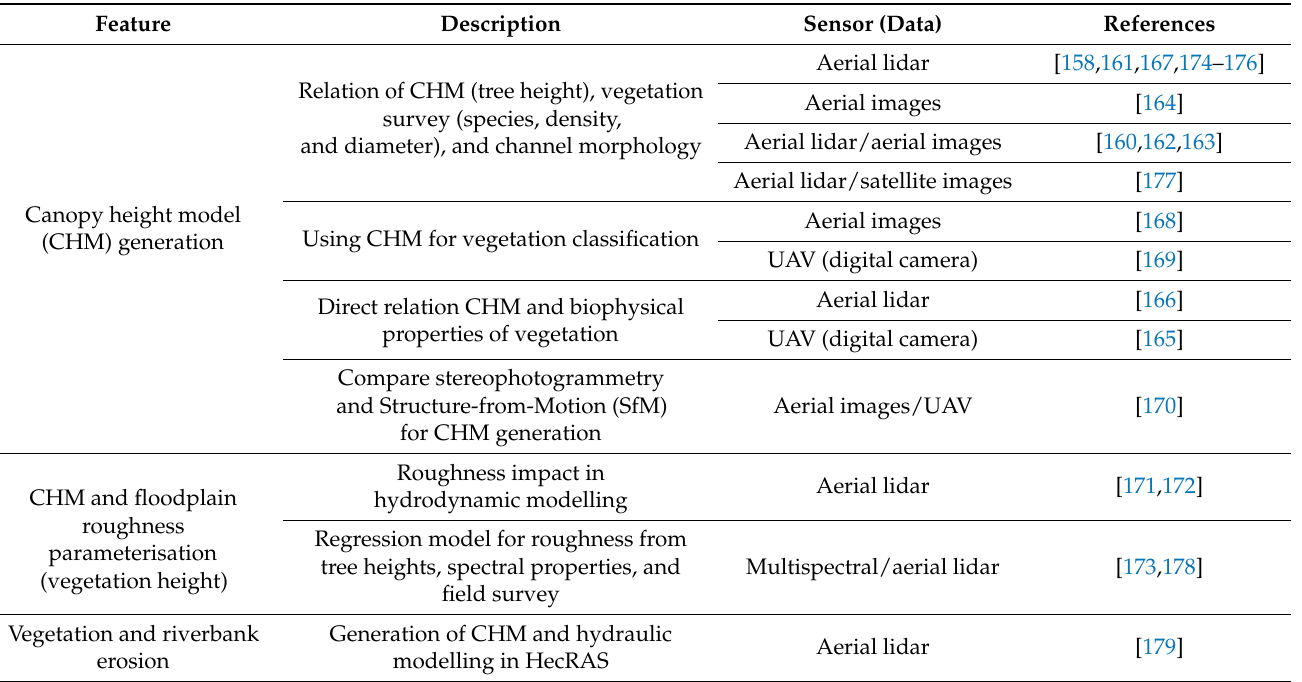
Table 3. Canopy height model (CHM) used for an assessment of the biophysical properties, relation- ship between the CHM and field surveys, vegetation classification, and roughness parametrisation. Studies are sorted based on a short description of the methodologies and sensors